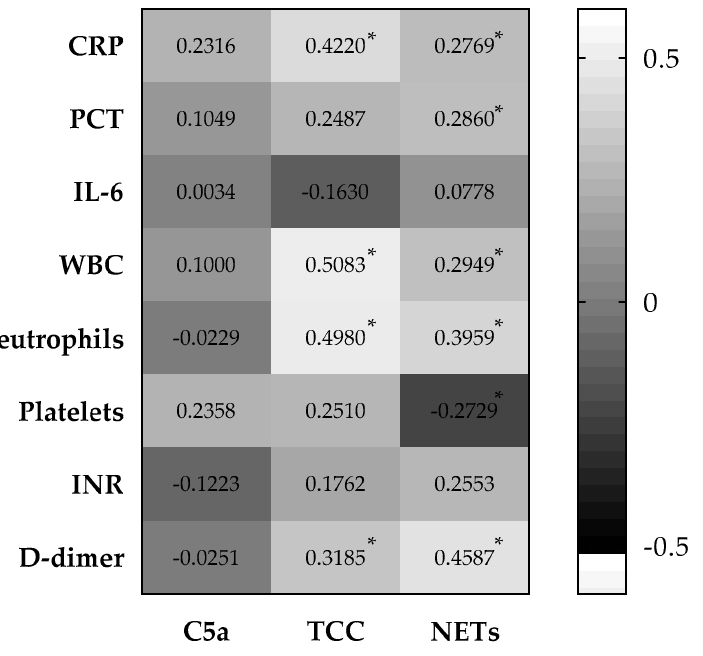
Figure 3. Correlation matrix of activation in systemic parameters. Complement activation products, C5a and TCC, and NETs release correlated with common inflammation and coagulation markers in mechanically ventilated patients with SARS-CoV-2 infection. Correlation coefficient was assessed using the Spearman rank correlation test. Values indicate Spearman r. CRP, C-reactive protein; PCT, procalcitonin; IL-6, interleukin 6; WBC, white blood cell count; INR, international normalized rate; TCC, terminal complement complex; NETs, neutrophilic extracellular traps. * p < 0.002 (significant after Bonferroni